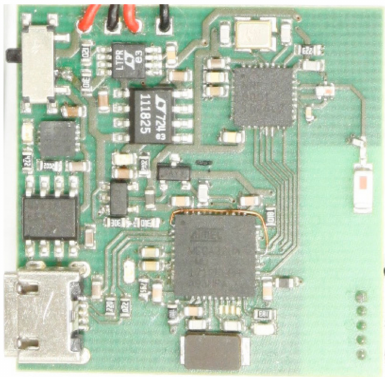
Figure 16. Image of the actual 10-Bit derivative bioimpedance acquisition system prototype.